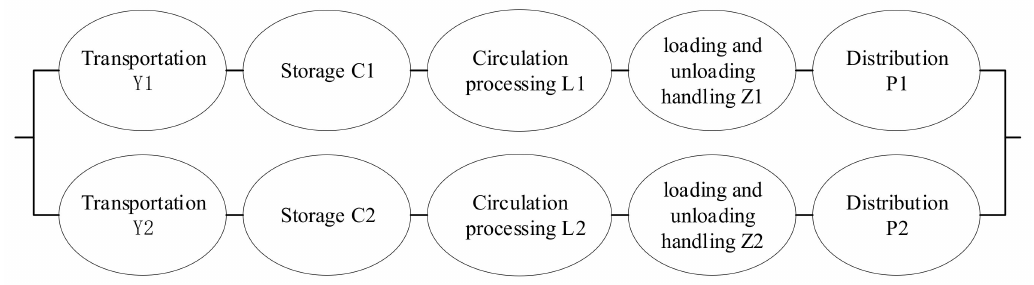
Figure 4. Structural diagram of a typical series parallel logistics